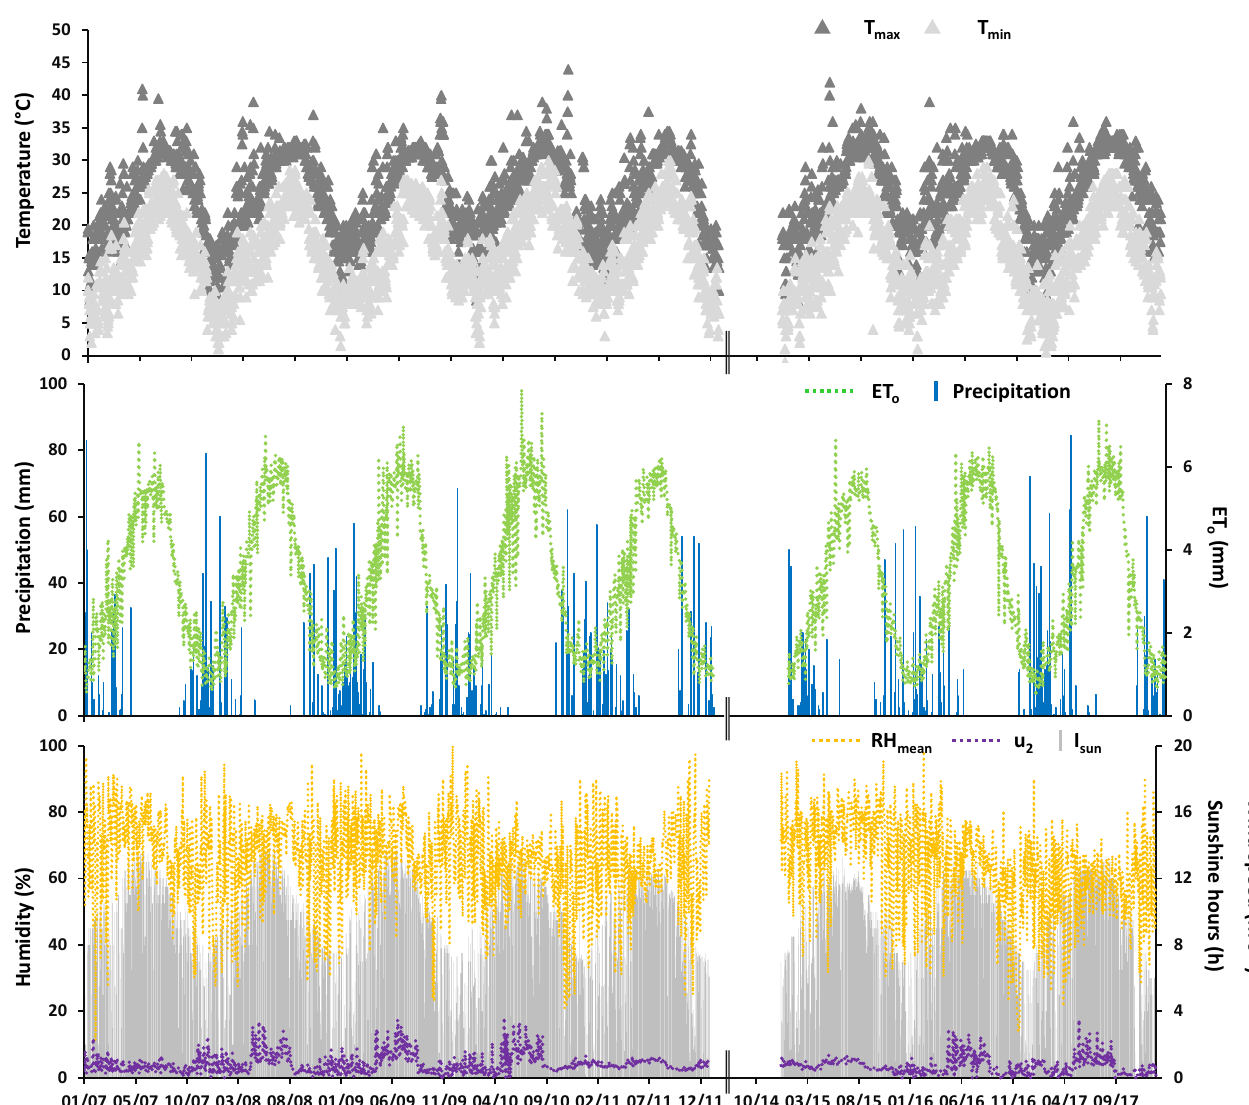
Figure 1. Daily maximum (T max ; °C) and minimum (T min ; °C) air temperatures, mean relative humid- ity (RH mean ; %), number of sunshine hours (I sun ; h), wind speed at a 2 m height (u 2 ; m s − 1 ), precipita- tion (mm), and grass reference evapotranspiration (ET o ; mm) for the 2007–2011 and 2015–2017 years. The dominant soil reference groups in the Akkar plain are Vertisols, Cambisols, and Luvisols [55]. Irrigated agricultural land, which is supplied by surface water resources, covers 29,100 ha in the Tartus district and 38,000 ha in the Latakia district [7].